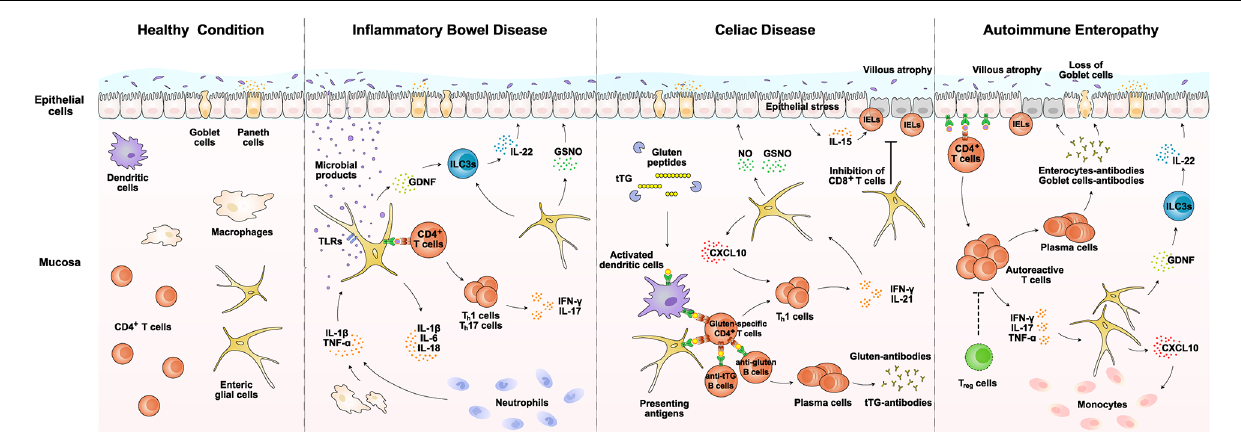
FIGURE 2 | EGCs in immunological disorders of the gut. EGCs exert potential roles in several important immunological disorders of the gut, including inflammatory bowel disease, celiac disease, and autoimmune enteropathy. EGCs could directly sense invading pathogens via specific TLRs and release pro-inflammatory cytokines such as IL-1 β and IL-6. Also, EGCs are able to produce CXCL10 and facilitate the recruitment of lymphocytes or monocytes. In addition, EGCs may present disease-related antigens via MHC-II to CD4+ T cells. Moreover, EGCs would produce GDNF and GSNO that indirectly or directly modulate the epithelial integrity. Details of the immune functions of EGCs are described in the main text. Notably, different subtypes of EGCs are not particularly distinguished for immune functions in this diagram. GDNF, glial cell line-derived neurotrophic factor; GSNO, S-nitrosoglutathione; IELs, intraepithelial lymphocytes; ILC3s, type 3 innate lymphoid cells; NO, nitro oxide; TLRs, Toll-like receptors; tTG, tissue